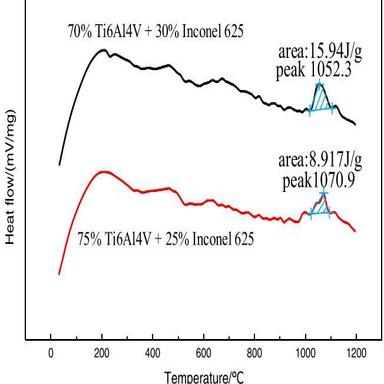
The characteristic transformation temperatures in different deposition areas.